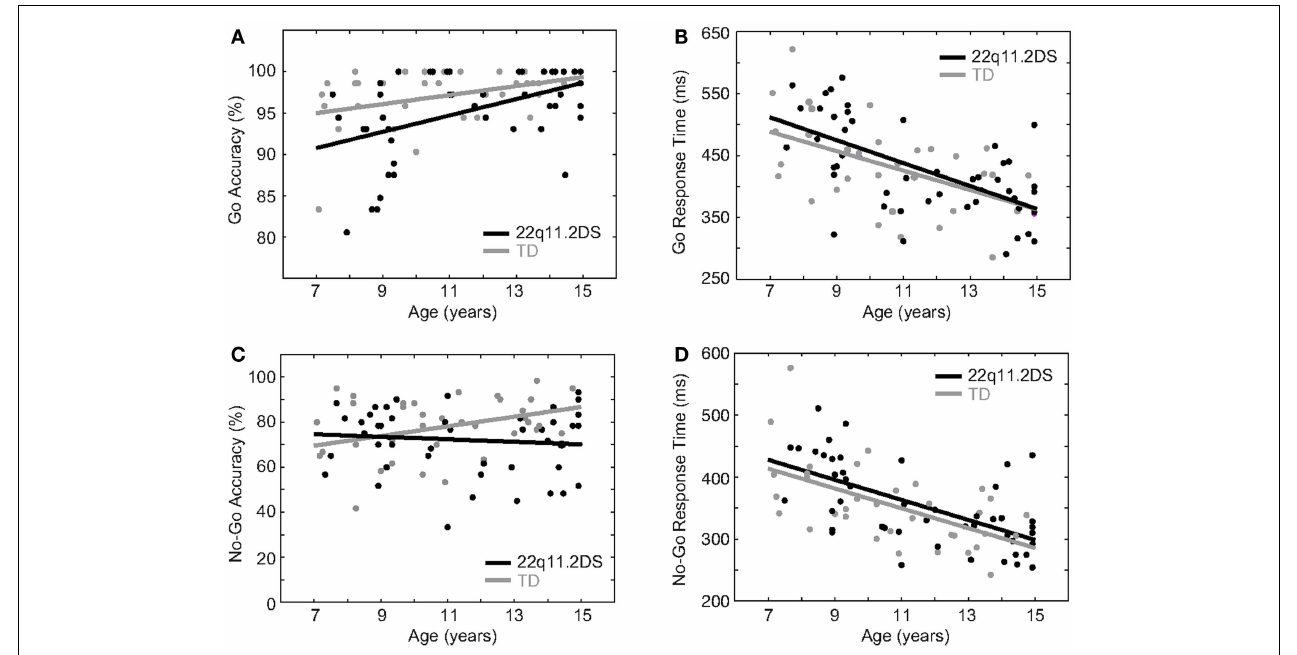
in olderTD children relative to younger, but this was not the case in children with 22q11.2DS. (D) Both groups demonstrated a similar relationship of faster No-Go (false alarm) RT and